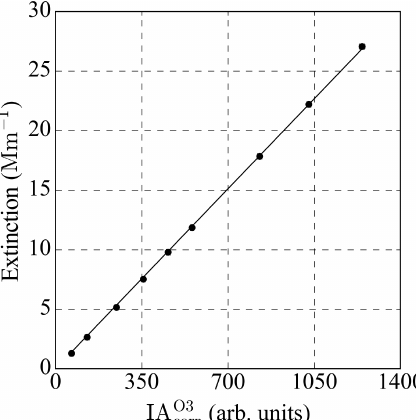
Figure 3. Photoacoustic spectrometer response (microphone inte- grated area; IA) and concurrent cavity ring-down spectrometer ex- tinction coefficient for nine ozone concentrations at wavelength 405nm. Each point is the mean of 90s of 1Hz data and error bars represent the 2 σ precision of each measurement; these are not dis- cernible by eye due to the excellent